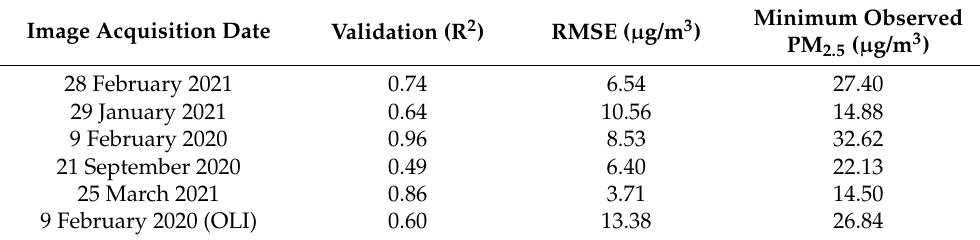
Table 7. Validation and RMSE results for the 2019–2021 study period.